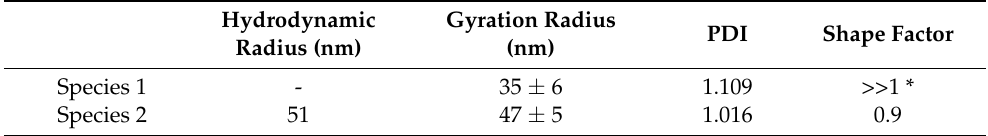
Table 3. Summary of the size and morphology information of the two populations separated and characterized through FFF multidetection. Hydrodynamic Gyration Radius Radius (nm)